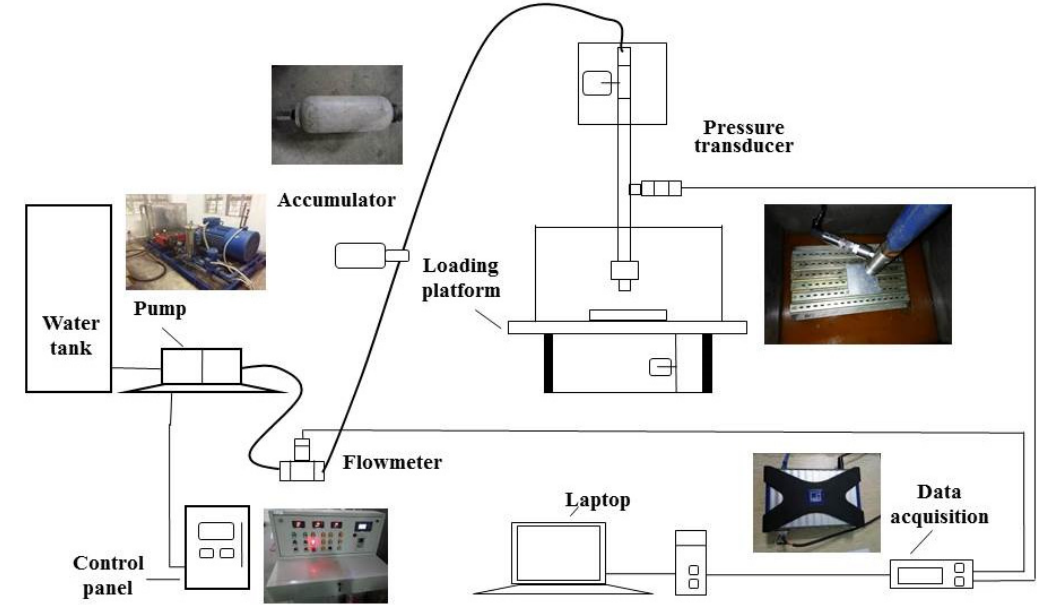
Figure 2. Schematic diagram of experimental apparatus.